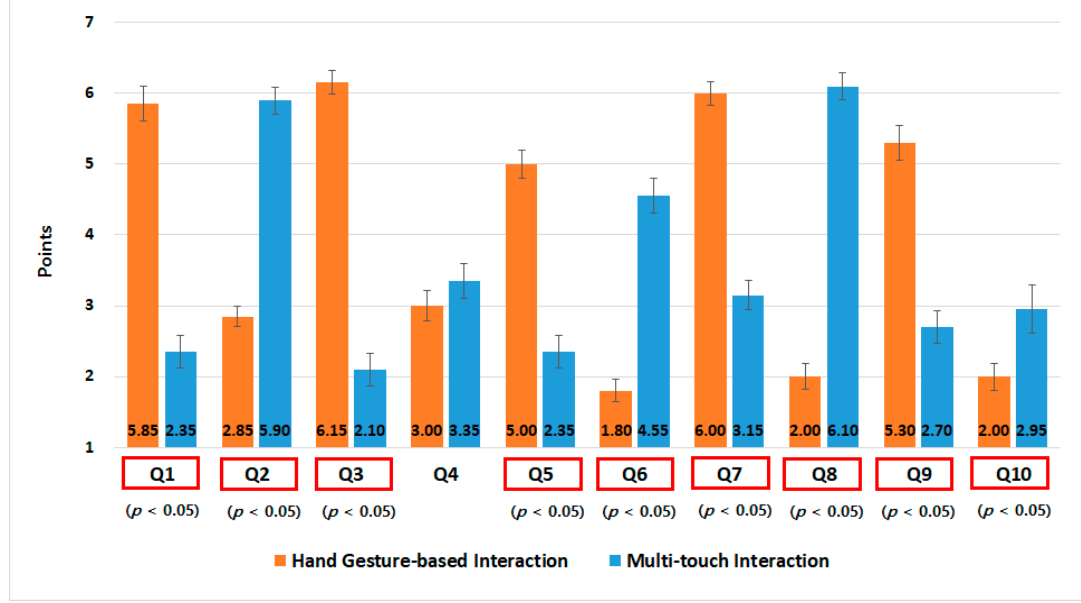
Figure 18. Qualitative results for gesture interaction.